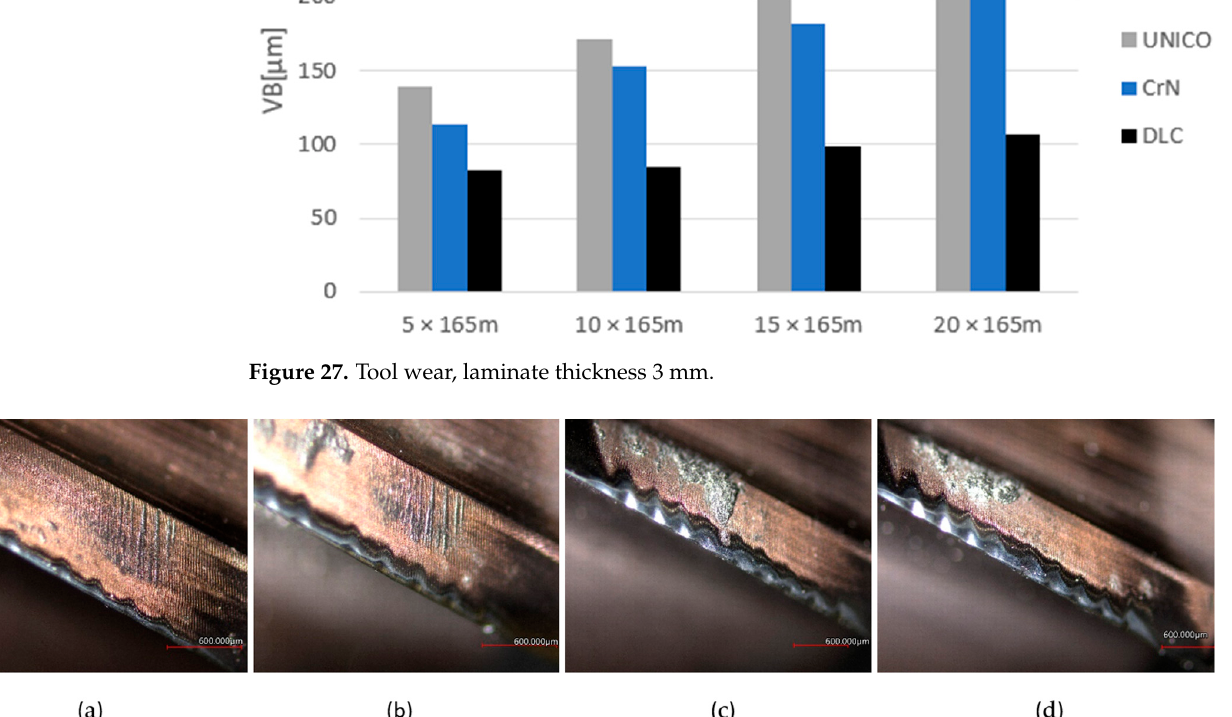
Figure 28. Tool wear of the G550 milling tool, laminate thickness 3 mm. ( a ) Tool tooth path 5 × 165 m; ( b ) tool tooth path 10 × 165 m; ( c ) tool tooth path 15 × 165 m; ( d ) tool tooth path 20 × 165 m.